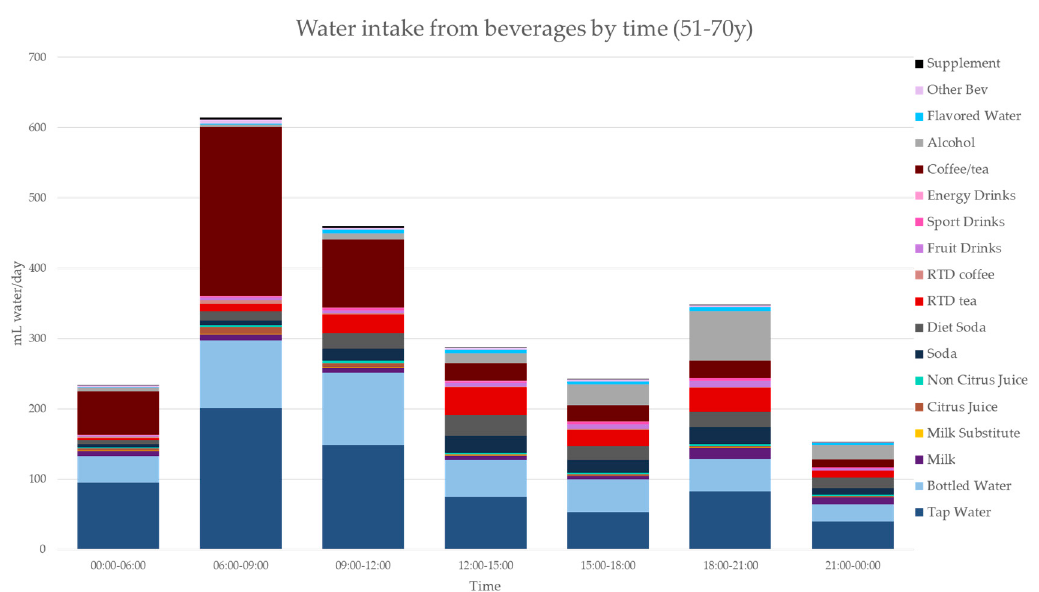
Figure 7. Water intakes (mL/d) by beverage type and time of day for the 31–50 y age group (NHANES 2011–2016).